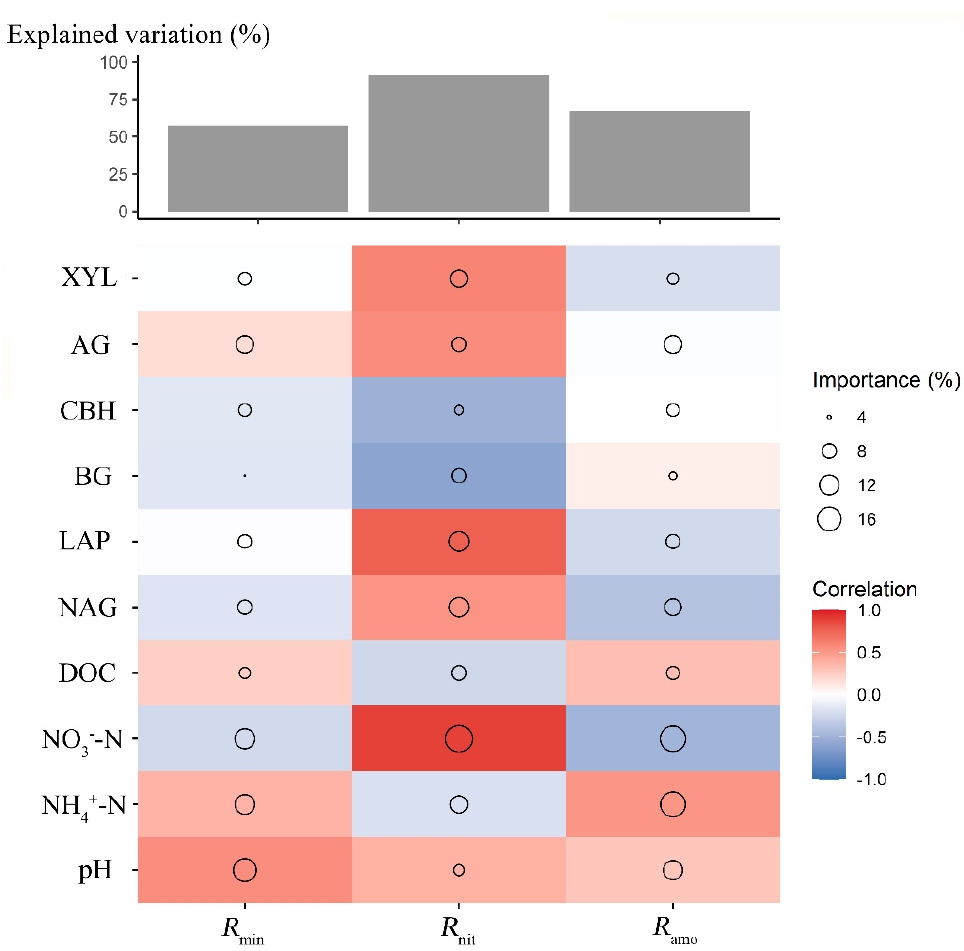
Figure 6. Random Forest heatmap indicating relationship of nitrogen transformation rate and soil variables. Circle size represents the variable importance (that is, proportion of explained variability calculated via multiple regression modeling and variance decomposition analysis based on out − of − bag CV). Colors represent Spearman correlations (n = 90). R min , Soil net N mineralization rate; R nit soil net nitrification rate; NAG, β − 1,4 − N − acetylglucosaminidase; LAP, leucine aminopeptidase; BG, β − 1,4 − glucosidase; CBH, β − D − cellobiosidase; AG, α − 1,4 − glucosidase; XYL, β− xylosidase.